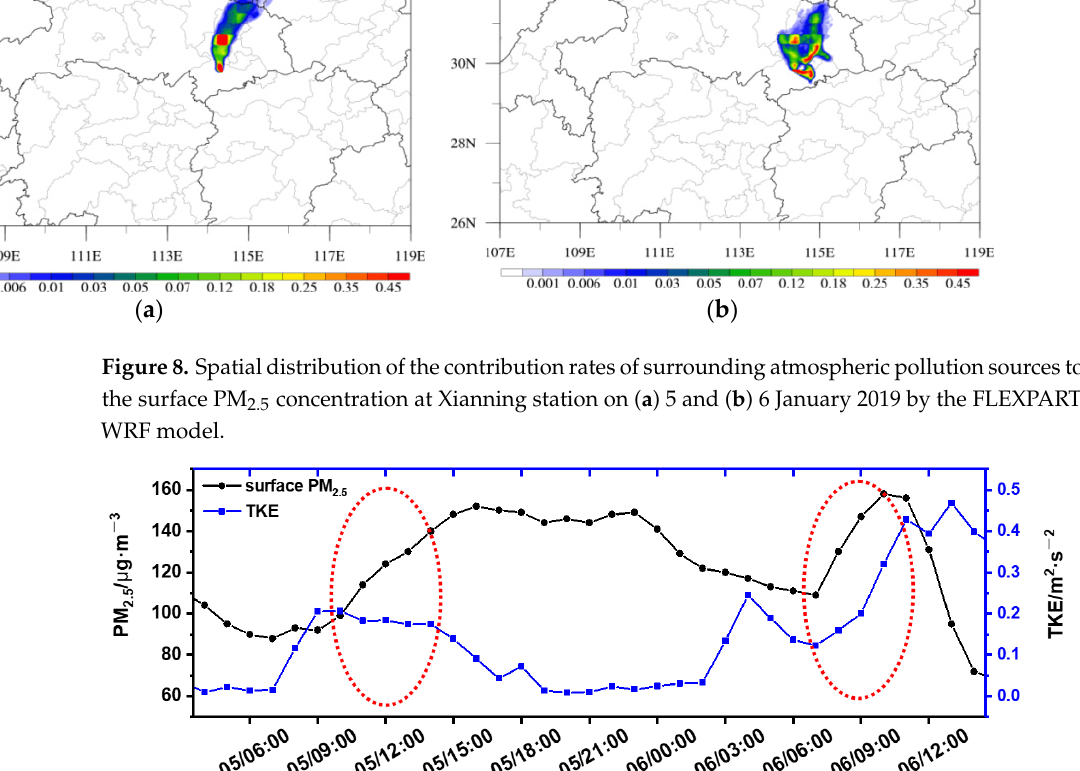
Figure 8. Spatial distribution of the contribution rates of surrounding atmospheric pollu- tion sources to the surface PM 2 . 5 concentration at Xianning station on ( a ) 5 and ( b ) 6 Jan- uary, 2019 by the FLEXPART-WRF model.